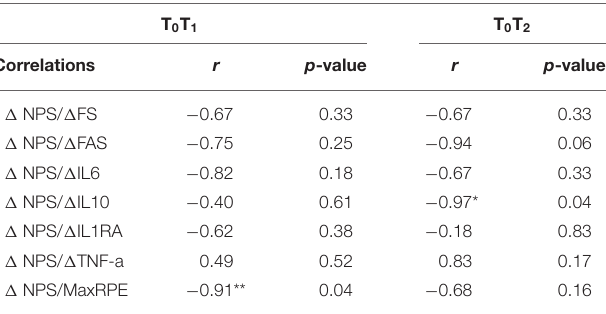
TABLE 3 | Correlations between changes in pain, changes in affect, changes in arousal, and changes in cytokines among persons with tetraplegia ( n = 4). T 0 T 1 T 0 T 2